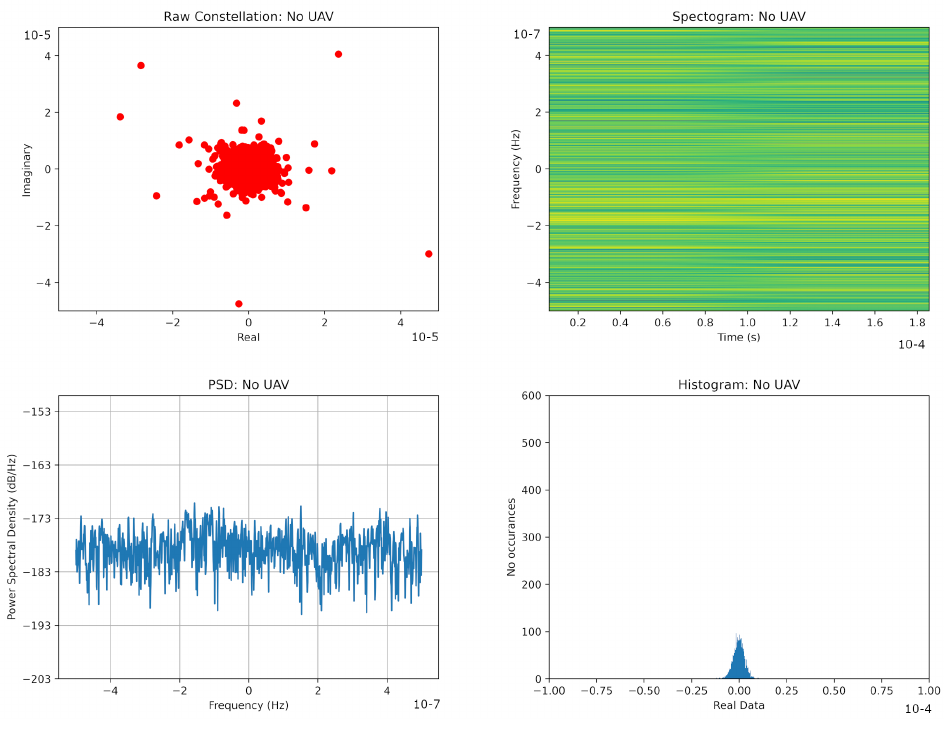
Figure 3. No UAV Present.